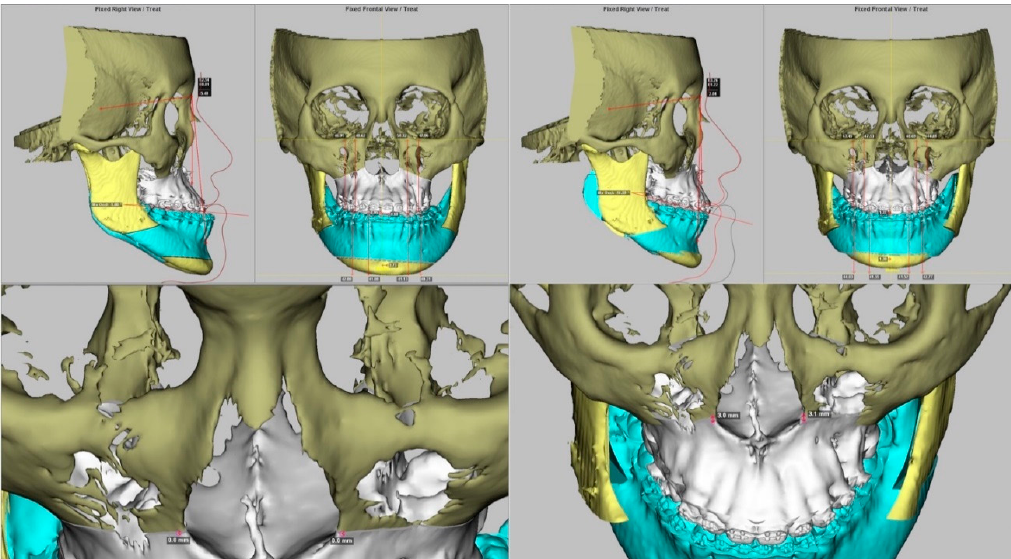
Figure 8. Practical examples of different compositions of the maxillary advancement and rotational movements for two-jaw orthognathic surgery in patients with a skeletal Class III pattern and midface deficiency. ( Left ) Actual deformity. ( Right ) Surgical simulation. The decision regarding the magnitude of each movement is based on key elements, including an accurate preoperative clinical evaluation- and 3D image-based diagnosis of the actual skeletofacial deformity (bone and soft tissue elements), the definition of patients’ complaints and requests, the achievement of a balanced, symmetric, and aesthetically pleasant facial appearance during computer-assisted simulation, and the surgical feasibility of the simulated bone mobilizations.